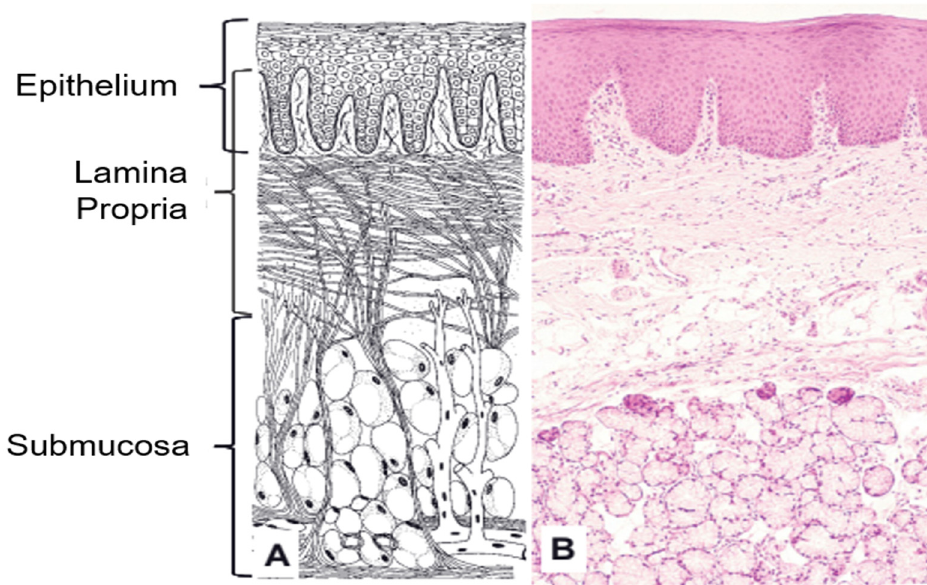
Figure 1. ( A ) Schematic diagram of the oral mucosa; ( B ) histological section of the hard palate to show the tissue components (Reprinted with permission from Chen et al., 2015 [9]).